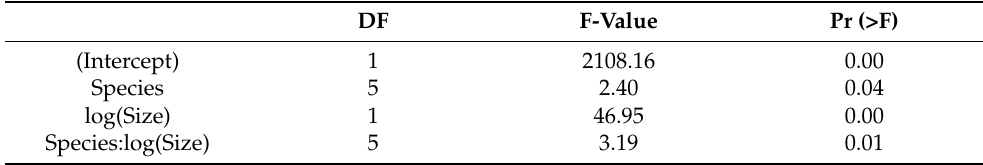
Table A6. ANOVA of model log ( φ a ) = Species × log ( Size ) .